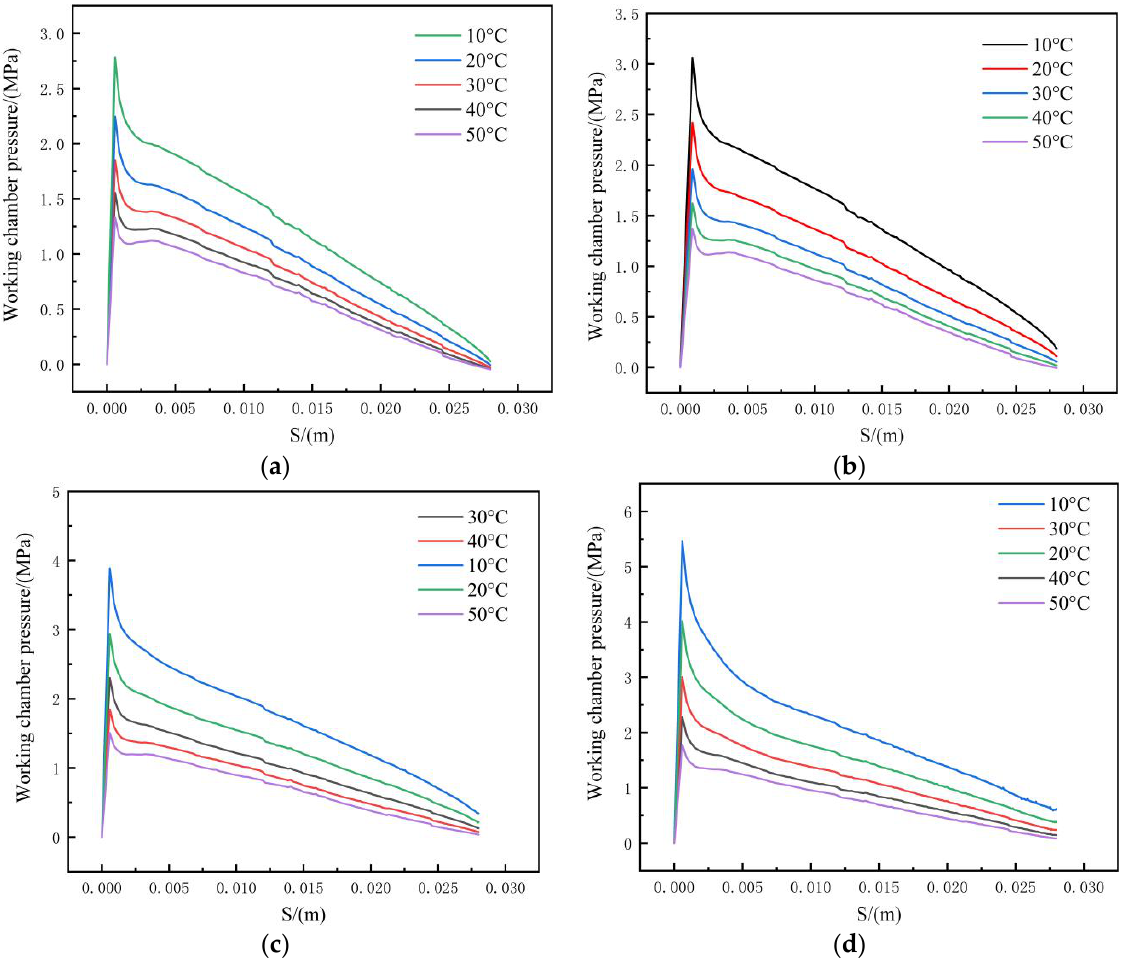
Figure 17. Curves of working chamber pressure and piston displacement when the current is 0 A, 0.5 A, 1 A and 2 A. ( a ) Working chamber pressure at 0 A; ( b ) working chamber pressure at 0.5 A; ( c ) working chamber pressure at 1 A; ( d ) working chamber pressure at 2 A.